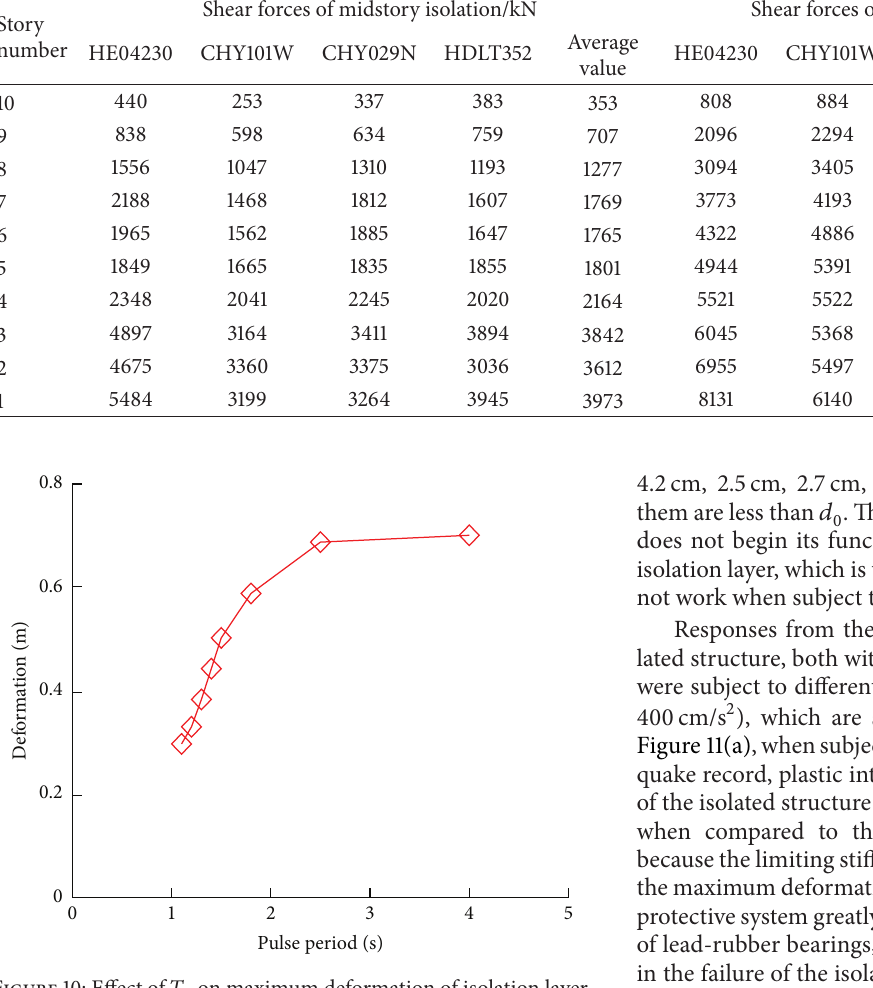
Figure 10: Effect of 𝑇 𝑝 on maximum deformation of isolation